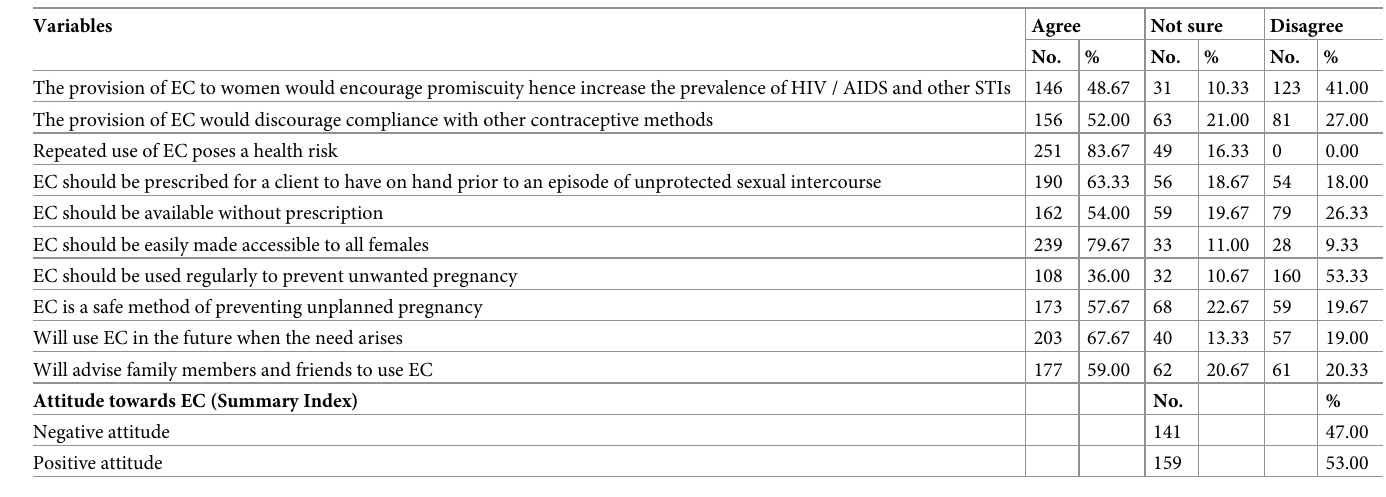
Table 3. Respondents’ attitude towards the use of emergency contraceptives (n =